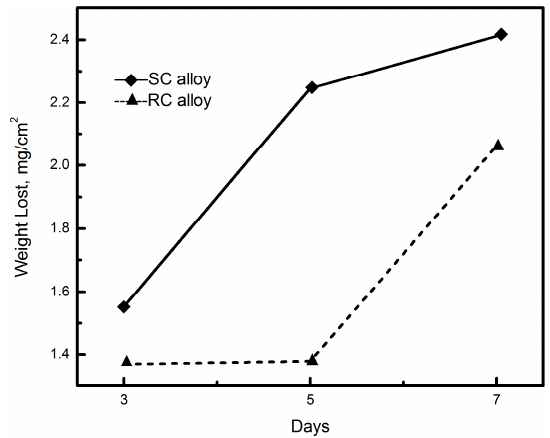
Figure 2. Weight loss of Sn–8Zn–3Bi alloy with two solidification rates as a function of duration time in 3.5% NaCl environment.